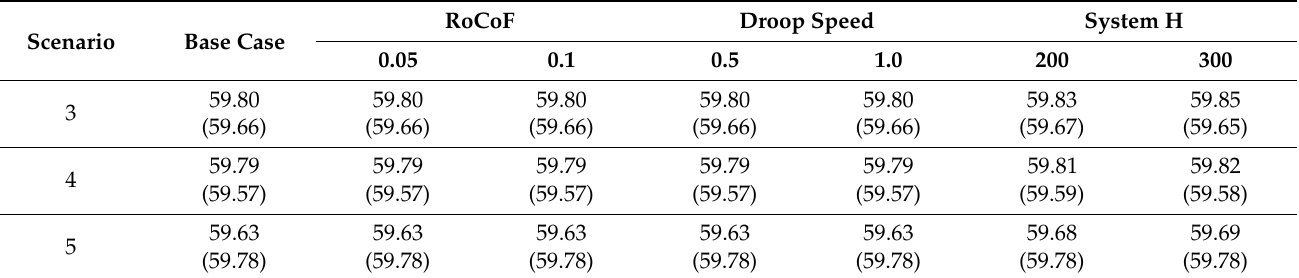
Table 12. Scenario C configuration (HVDC No.3 transmission). Scenario 1